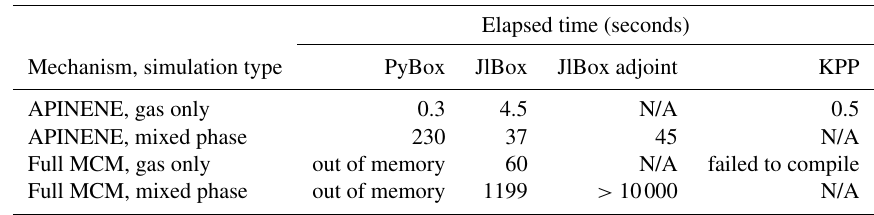
Table B2. Performance comparison of PyBox, JlBox and KPP based on elapsed time of forward and adjoint simulation in Sects. 4.1 and 4.2 and simulation of full MCM with the same initial condition.